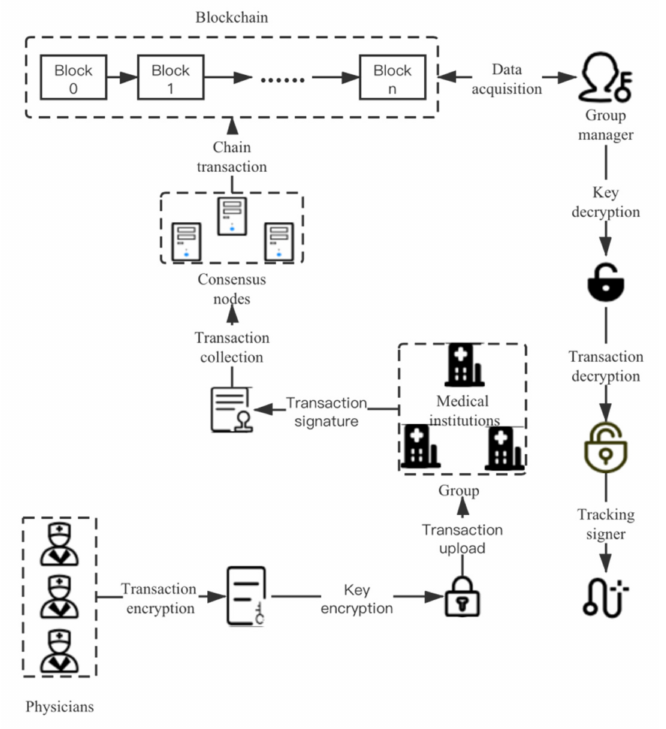
Figure 8. Overall system